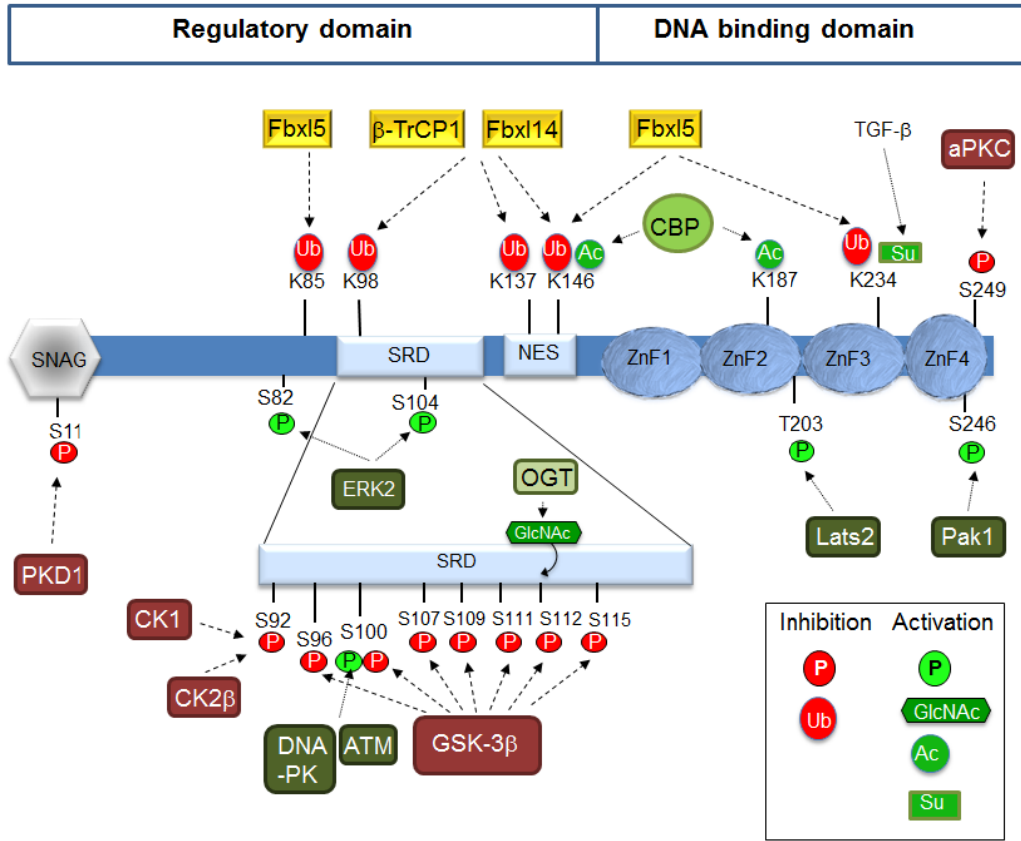
Figure 1. Post-translational modifications controlling Snail1 function. The figure shows a diagram of Snail1 protein with the N -terminal regulatory domain and the C -terminal DNA-binding domain. The SNAG, SRD, and NES elements are included in the N -terminal domain. The indicated covalent modifications of the amino acids are depicted in green or red if they activate or inhibit (respectively) Snail1 function. K48-mediated polyubiquitination is indicated by an oval (Ub); phosphorylation (P) and acetylation (Ac), by circles; glycosylation (NAcGlc), by a hexagon; sumoylation (Su), by a rectangle. The enzymes catalyzing these modifications are also shown when they have been described. Please notice that the phosphorylation of S100 can promote a positive or negative effect on Snail1 function depending on the protein kinase and the context. Only the F-box proteins acting on identified Lysine residues are shown.